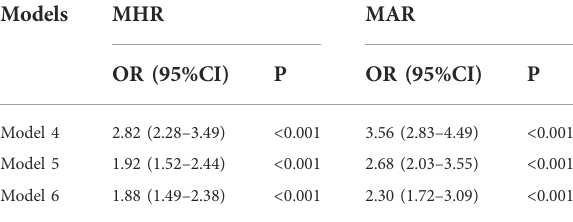
TABLE 5 Binomial Logistic Regression Analysis adjusted ORs (95% CIs) for the associations between MHR, MAR and the risk of